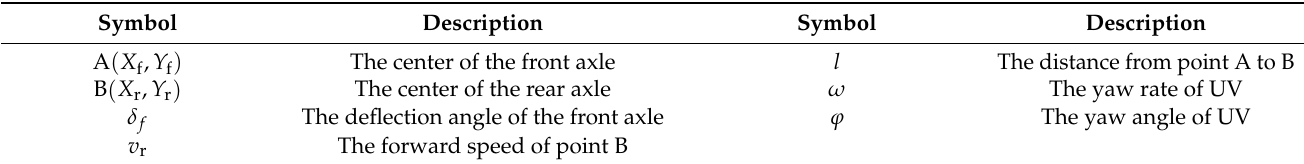
Figure 1. The 2-DOF kinematic model of UV. Table 1. The used symbols and parameters of